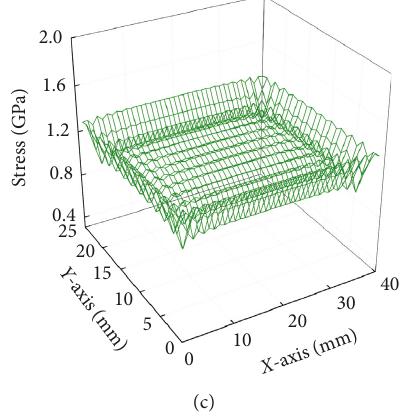
Figure 12: Typical FEM results of the hygroscopic stress: (a) 2 weeks, (b) 4 weeks, and (c) 6 weeks.